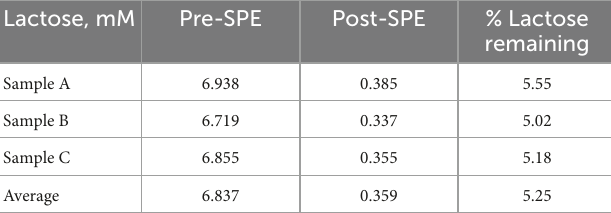
TABLE 1 Composition and quality control of the FTIR low fat bovine milk standards 1 . Fat, % Protein, % Lactose, % Standard FTIR Mojonnier FTIR Kjeldahl FTIR Calc by